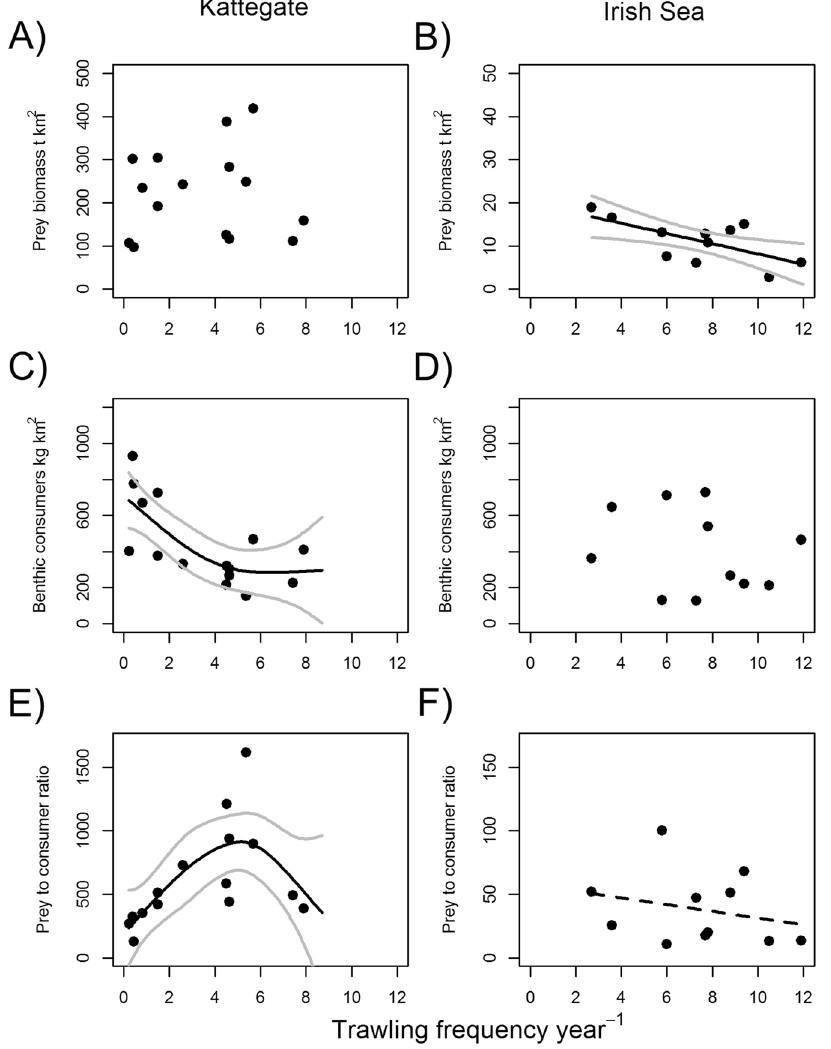
Figure 2. ( A,B ) Response of benthic biomass to trawling frequency ( A : Kattegat, B : Irish Sea). ( C,D ) Response of main benthic consumers (Plaice, Dab and Nephrops combined and additionally long rough dab in the Kattegat) to fishing pressure ( C : Kattegat, D : Irish Sea. E,F ). Note that y-axis scales of panels ( A , B ) as well as ( E , F ) are different. Benthic prey biomass to benthic consumer ratio (kg km 2 ) in relation to fishing intensity ( E : Kattegat, F : Irish Sea). Black lines represent significant GAM model relationships and grey lines their 95% confidence intervals. Dashed line in F signifies non-significant trend. Points represent mean values at